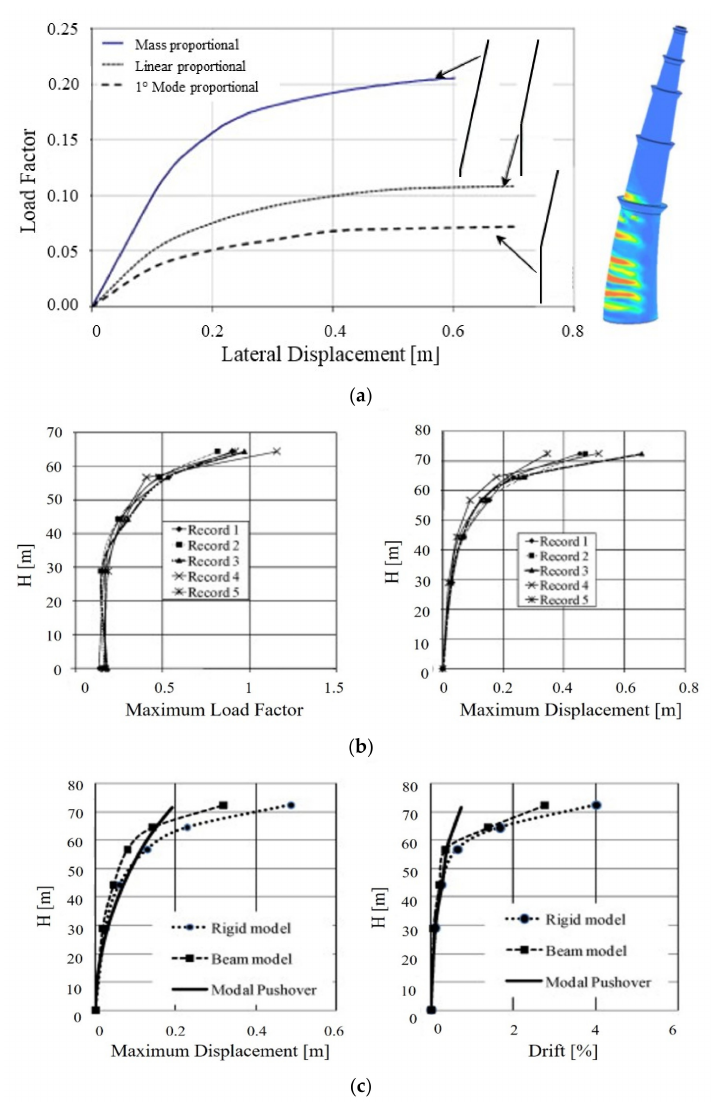
Figure 8. Seismic assessment of the Qutb Minar tower. Comparison of the results from different analysis methods [64]: ( a ) capacity curves for pushover analyses, ( b ) maximum load factor and displacements along the minaret height for dynamic analyses, ( c ) displacements and drifts along the minaret height for modal pushover and non-linear dynamic